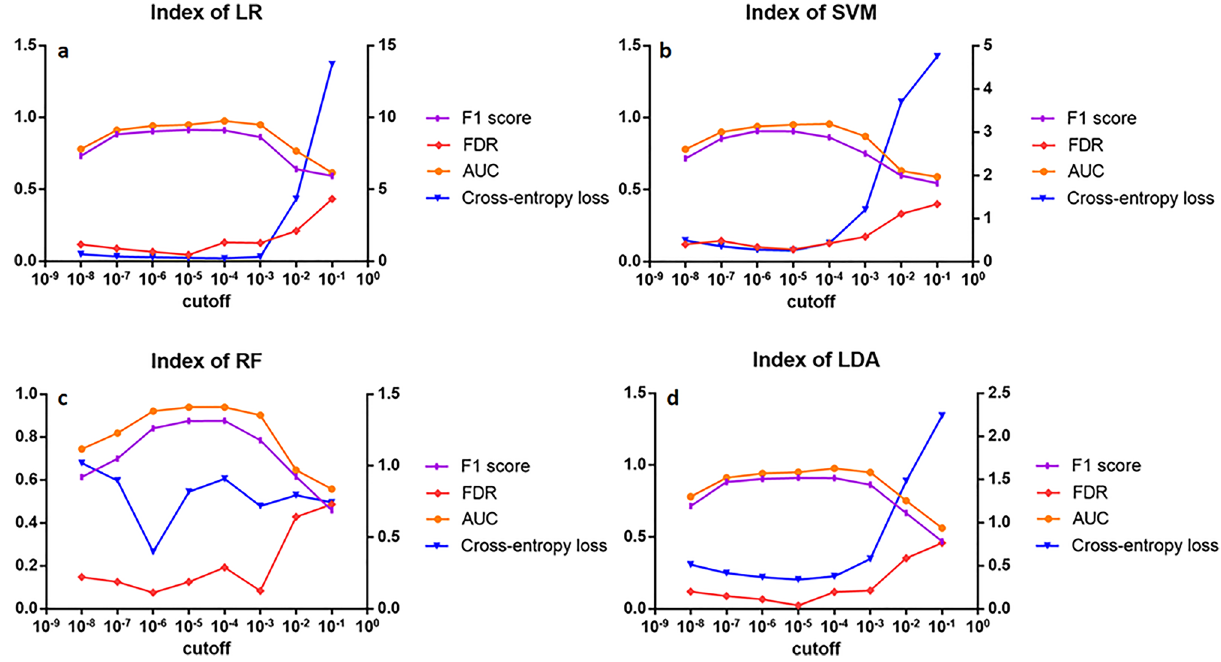
Figure 2. Evaluation metrics of algorithms. The scores of four algorithms of logistic regression (LR, a ), support vector machine (SVM, b ), random forest (RF, c ), and linear discriminant analysis (LDA, d ) were based on four evaluation metrics. The purple, red, orange, and blue curves represent the F1 score, FDR, AUC, and cross- entropy loss, respectively, with the first three indicators on the left Y-axis and the cross-entropy loss on the right Y-axis.